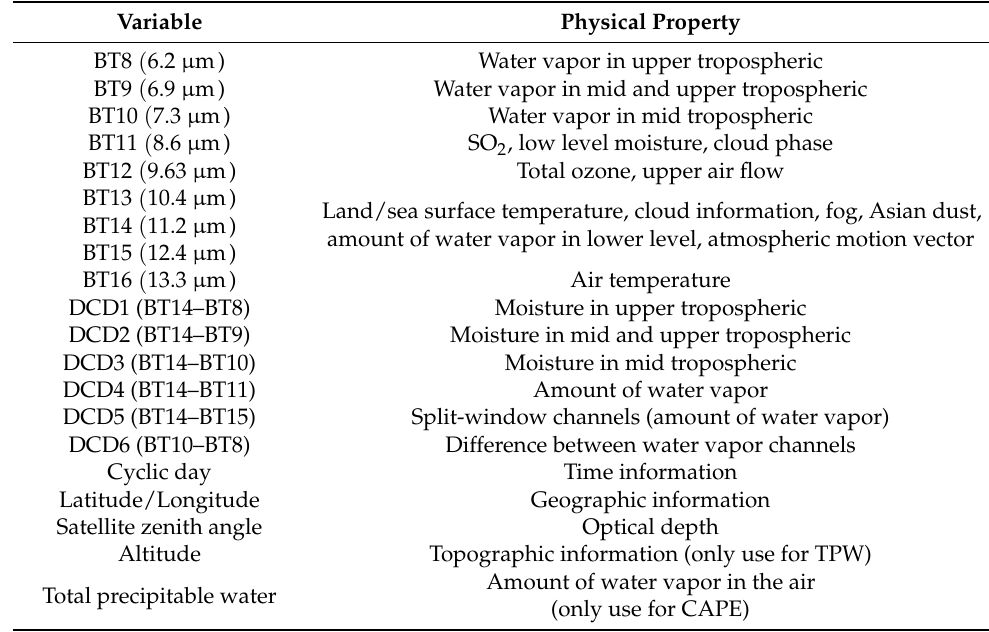
Table 2. Input variables used to retrieve TPW and CAPE. An abbreviation for each brightness temperature (BT) in channel 8 to 16 is BT8 to BT16, respectively. Dual channel difference is named DCD. The physical property of each input variable is